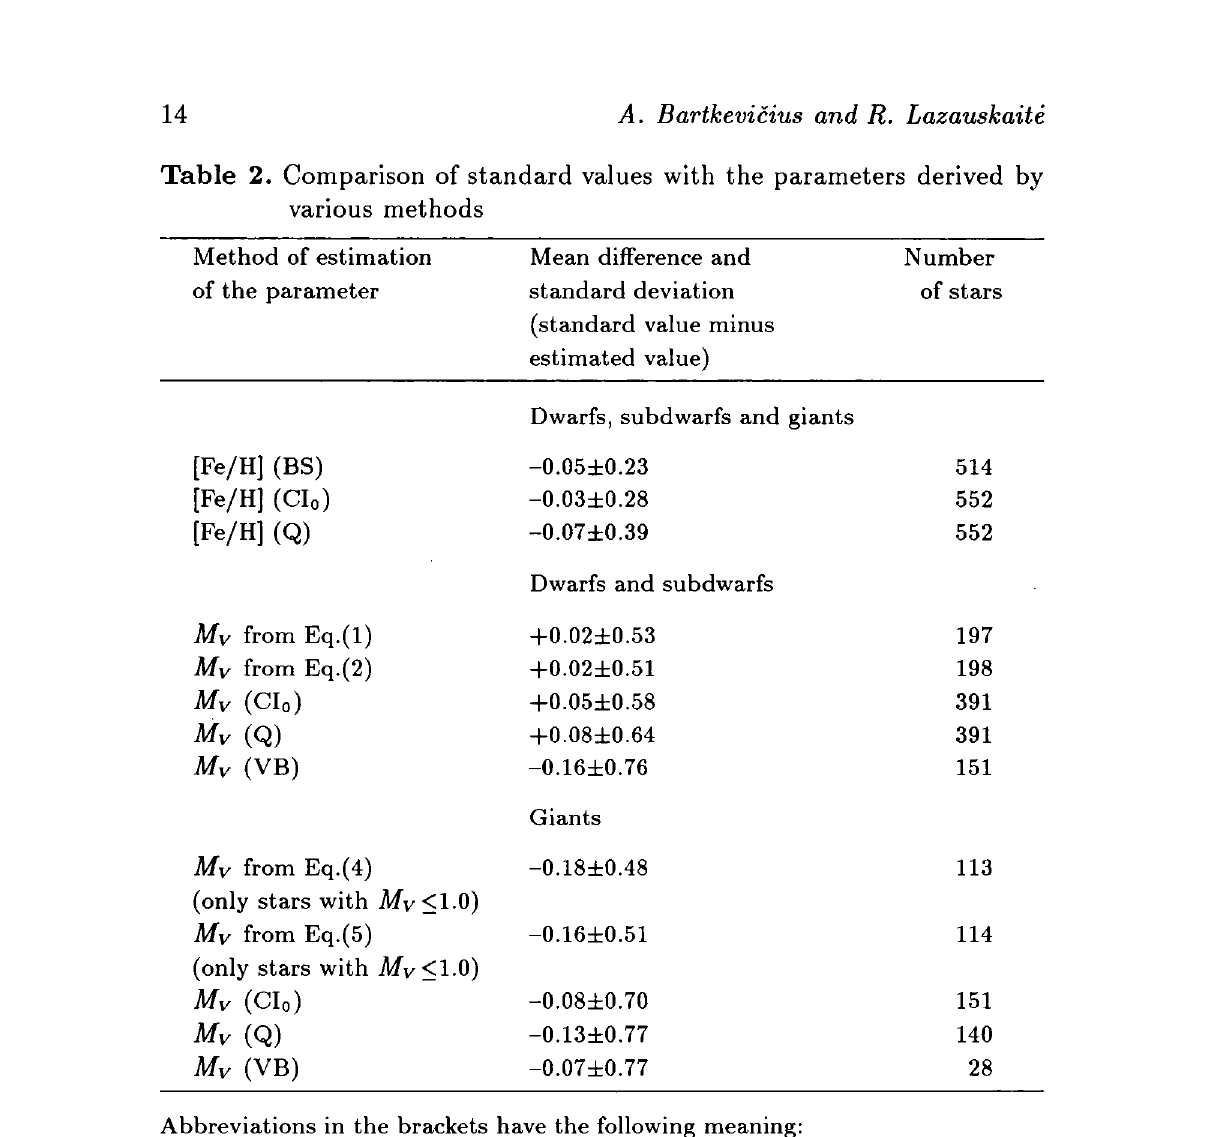
Table 2. Comparison of standard values with the parameters derived